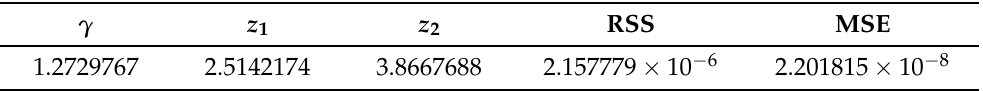
Table 4. Result of implementation of nlstac for pattern (14), with RSS being residual sum of squares and MSE = RSS / n where n = 98 is the number of observations.